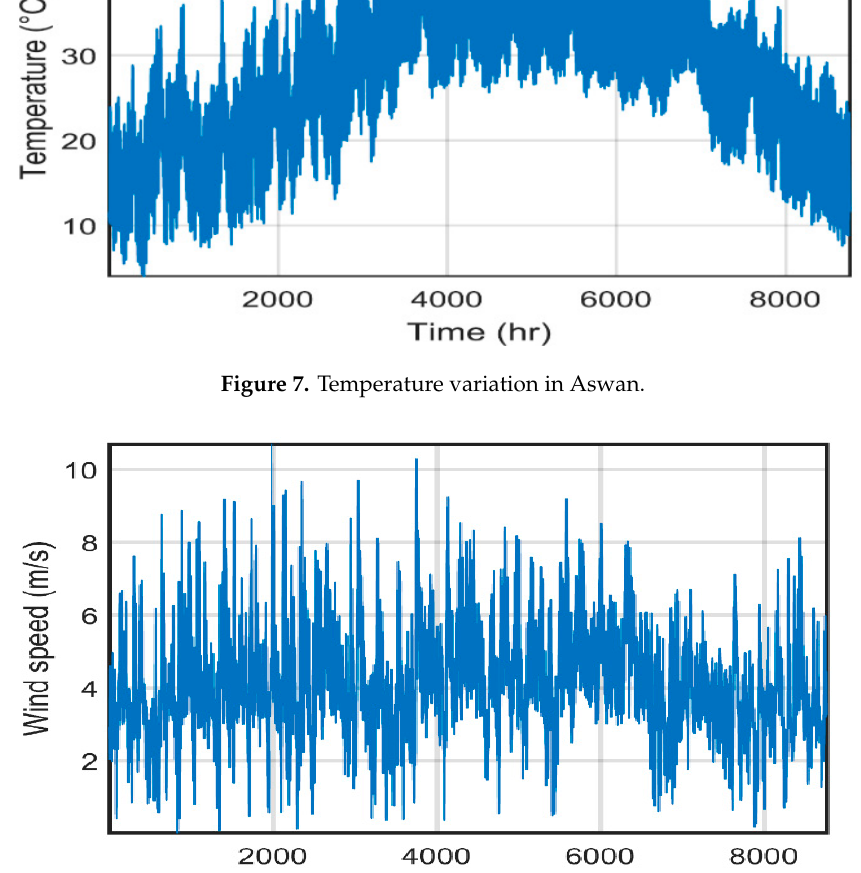
Figure 8. Annual variation of wind speed over the year in Aswan.